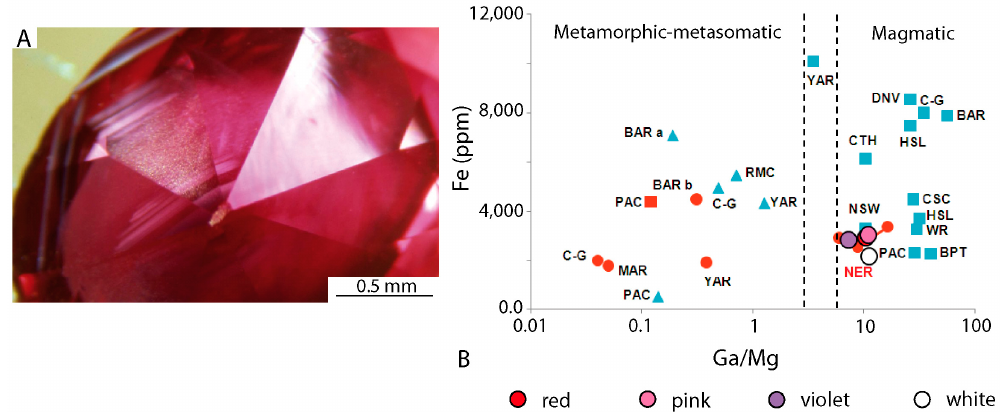
Figure 23. Rubies from the New England locality of Eastern Australia. ( A ) Apex culet view of an oval-cut 2.31 carats zoned ruby showing alternating growth zones passing through violet to white and pink bands and to ruby on the extreme margin of the top table, Collection Australian Museum. Photo: Gayle Webb; ( B ) Fe (ppm) versus Ga / Mg diagram for ruby and pink, violet, and white corundum from New England ruby (NER) and other Eastern Australian localities; chemical data from [86]. The red symbols indicate ruby, the blue triangles metamorphic sapphire suites, and the blue squares magmatic-transitional sapphire suites. The di ff erent localities are: NSW = New South Wales; BAR = Barrington Tops; YAR = Yarrowitch; C-G = Cudgegong-Gulgong; MAR = Macquarie River; WR = Weld River, NE Tasmania; PAC = Pailin, Cambodia; BPT = Bo Phloi, Thailand; HSL = Huai Sai, Laos; CSC = Changle, Shandong, China; DNV = Dak Nong, Vietnam; CTH = Chanthaburi-Trat, Thailand; RMC = Rio Mayo, Colombia.